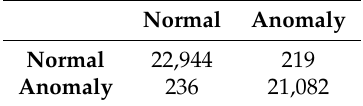
Table 27. Confusion matrix for Adaboost J48.